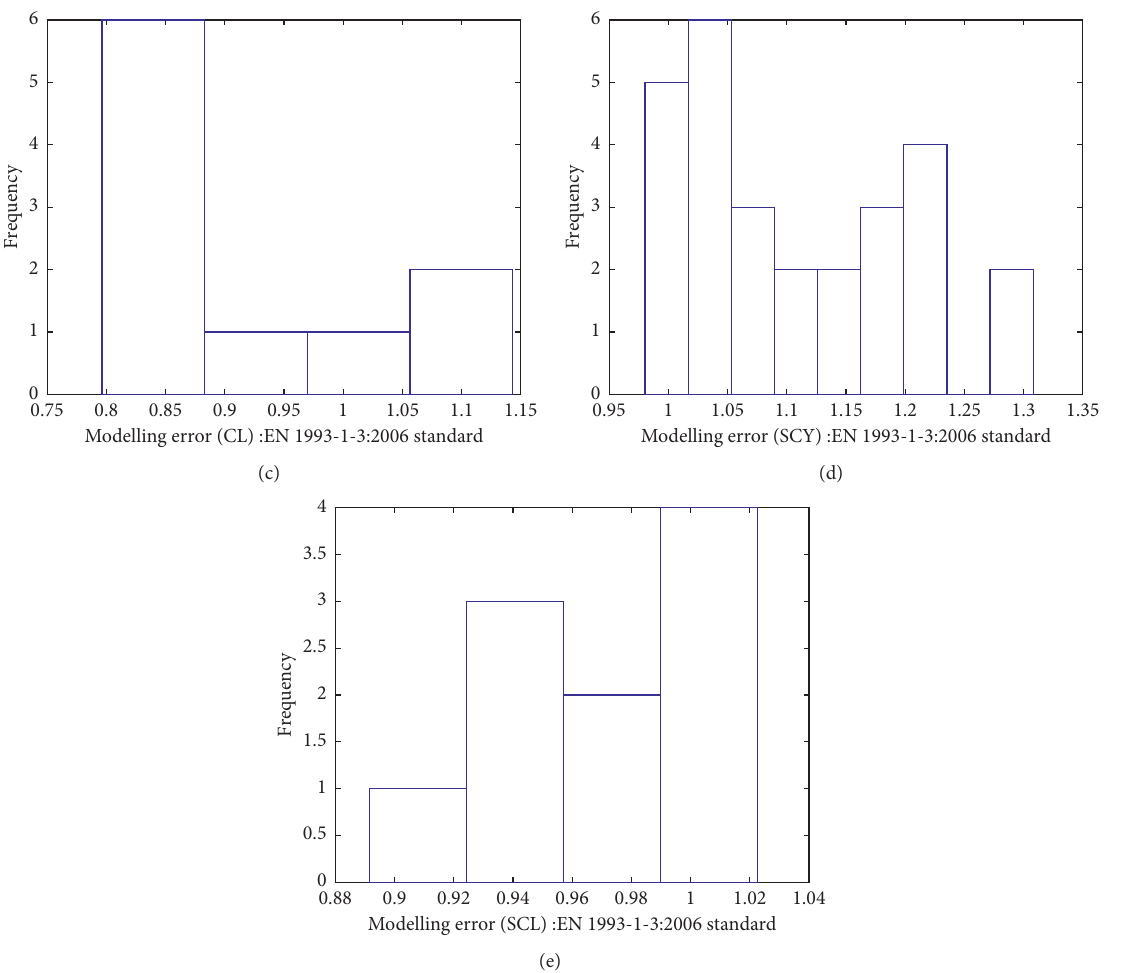
Figure 6: ME histograms for various failure modes for database member as per ASCE 10-15 Standard. (a) CF—column flexure; (b) CFT—column flexure-torsion; (c) CL—column local buckling; (d) SCY—stub column yielding; (e) SCL—stub column local